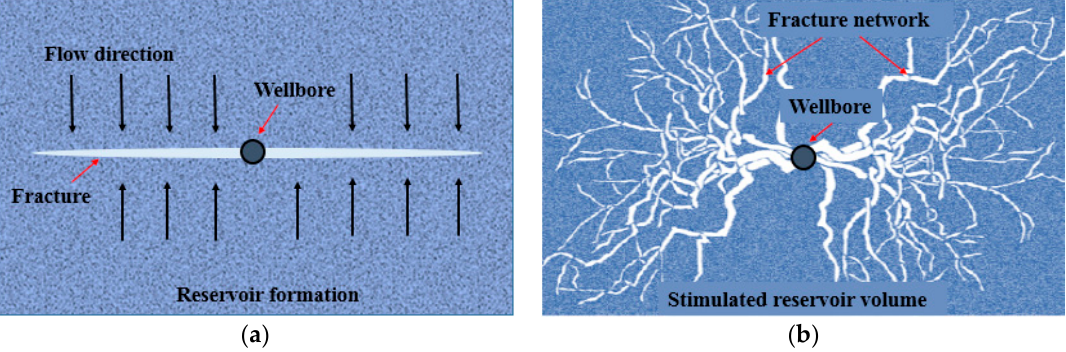
Figure 1. Schematic of conventional hydraulic fracture and fracture network by volume fracturing: ( a ) Conventional fracture, ( b ) fractures by volume fracturing treatment.